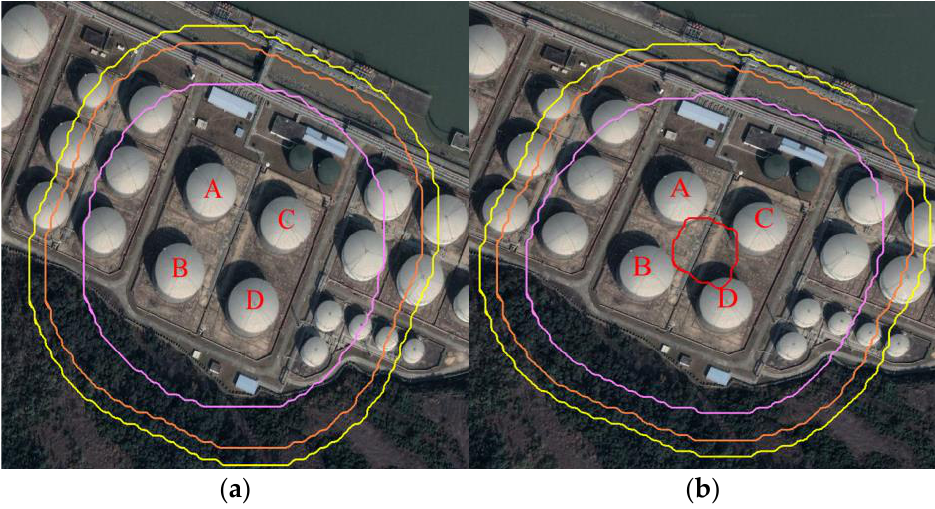
Figure 13. Individual risk analysis of storage tanks. ( a ) Without considering the synergistic effect ( b ) Considering the synergistic effect.